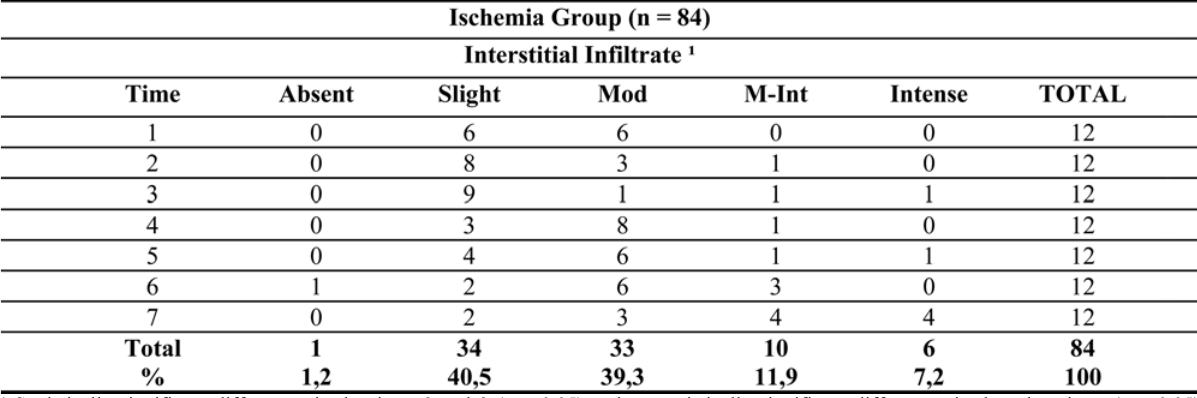
TABLE 3 – Interstitial infiltrate score in the ischemia group (n=84).